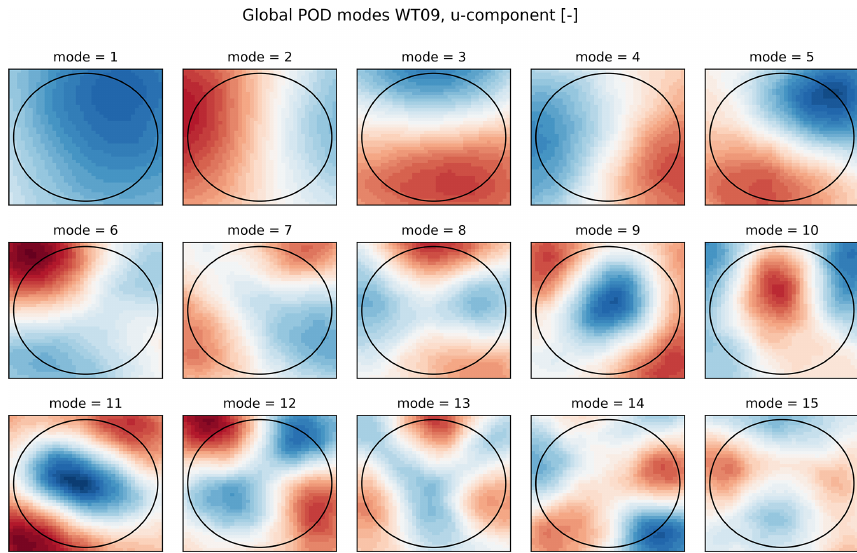
Figure 5. First 15 global POD modes, u component; note that each mode also has v and w fluctuating velocity components.